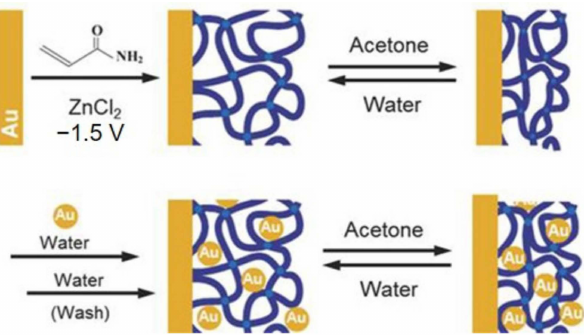
Figure 2. Construction of Au nanoparticles and hydrogel composite by switching between its swollen and shrunken states [23]. Copyright @ 2001 John Wiley and